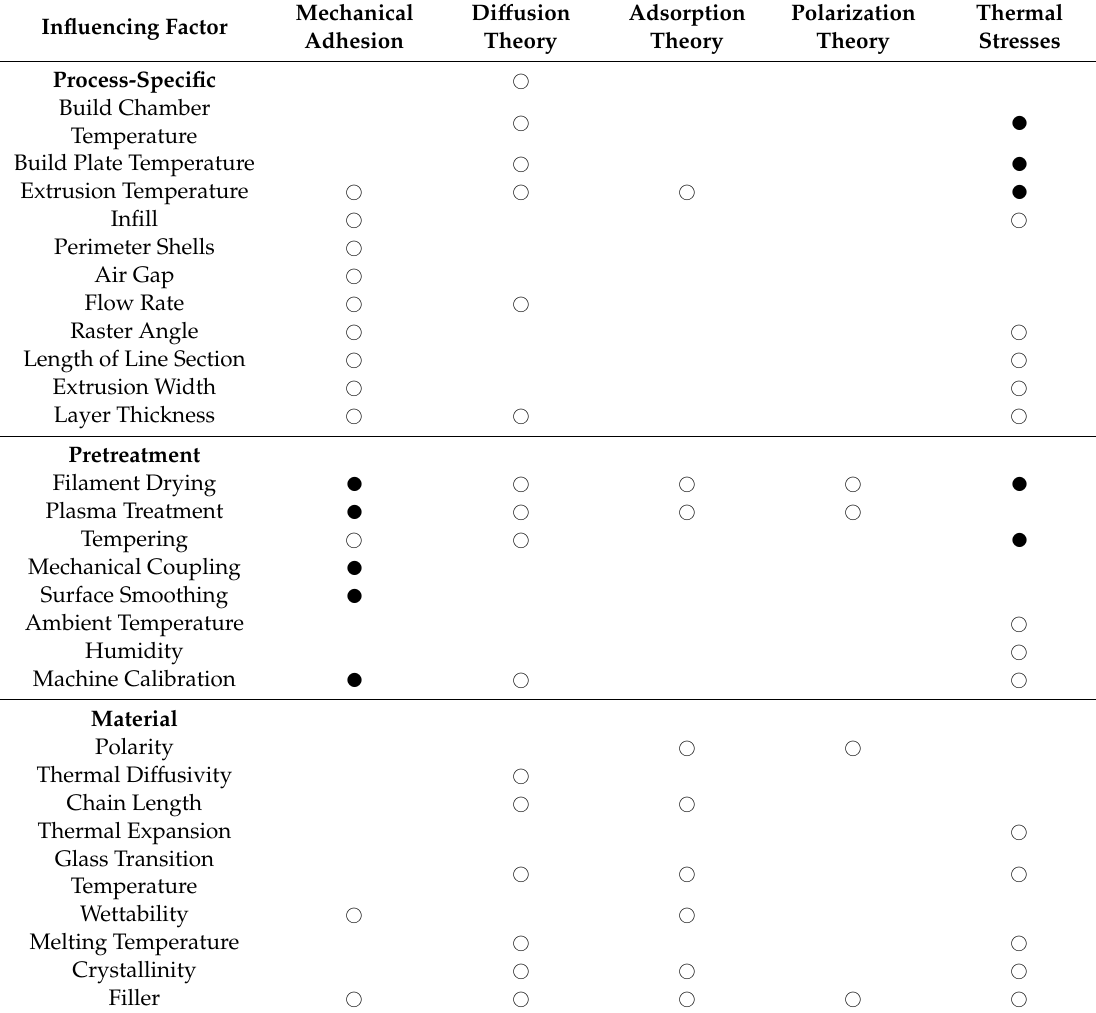
Proposed influence). (cid:35) Mechanical Di ff usion Adsorption Polarization Thermal Adhesion Theory Theory Theory Stresses (cid:35) Build Chamber